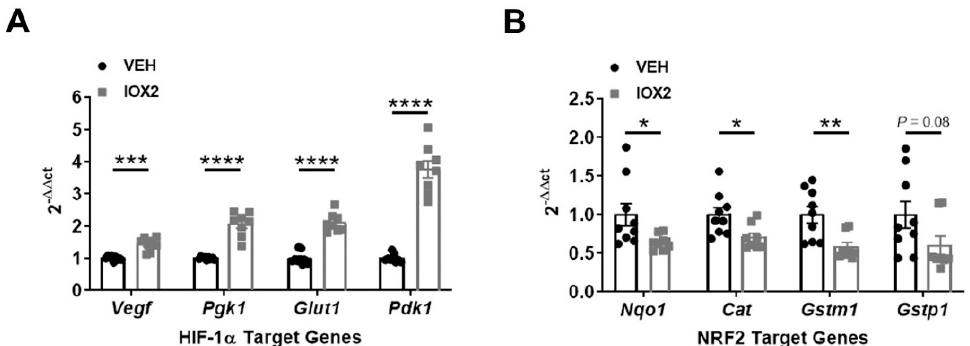
Figure 4. IOX2-mediated HIF-1 α activation decreases NRF2 target genes. ( A ) HIF-1 α target genes, Vegf , Pgk1 , Glut1 , and Pdk1 , increase in response to IOX2 (37.7 mg/kg). ( B ) NRF2 target genes, Nqo1 , Cat , Gstm1 , and Gstp1 , decrease in response to IOX2. Bars are mean ± S.E.M. Unpaired Student’s t -test. * p < 0.05, ** p < 0.01, *** p < 0.001, and **** p < 0.0001.